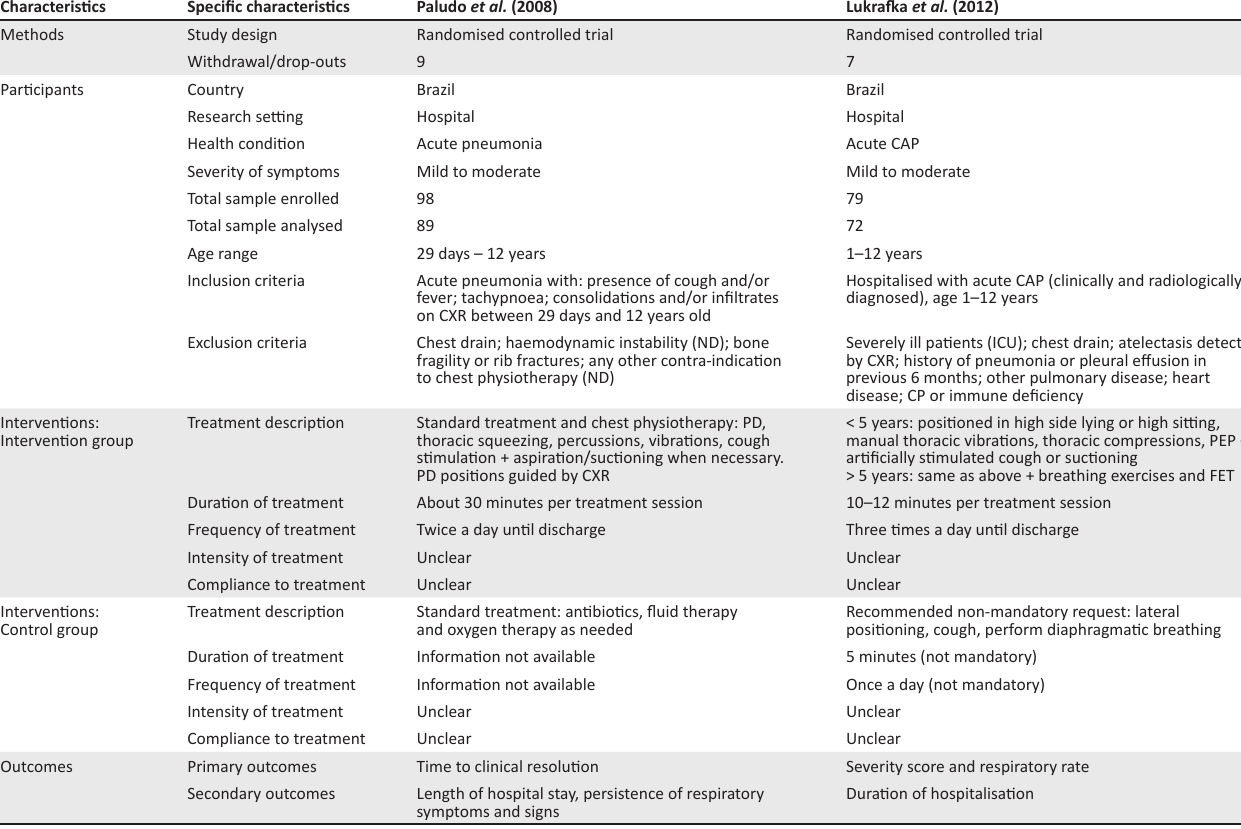
TABLE 1: Characteristics of included studies. Characteristics